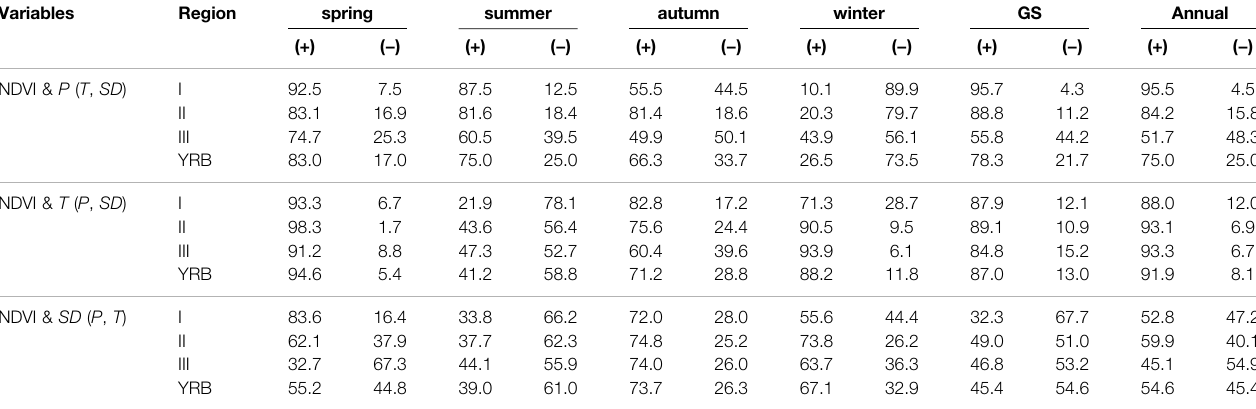
TABLE 4 | Area percentage of NDVI response to climate variables in the Yellow River basin at different timescales (%). Variables Region spring